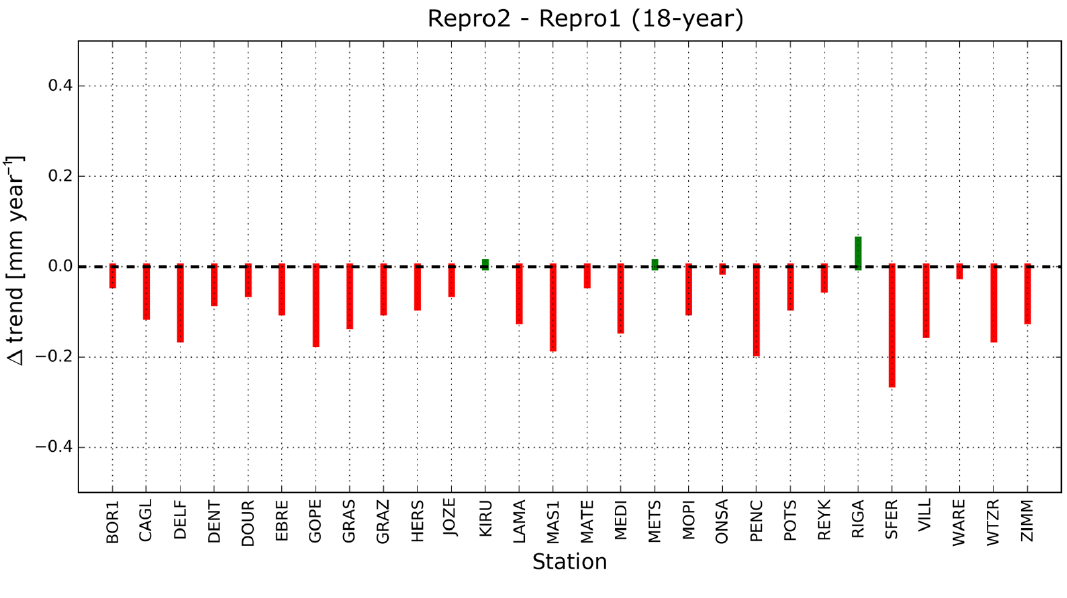
Figure 8. Differences between the values of the 18-year linear trends obtained from the Repro2 and the Repro1 campaigns.